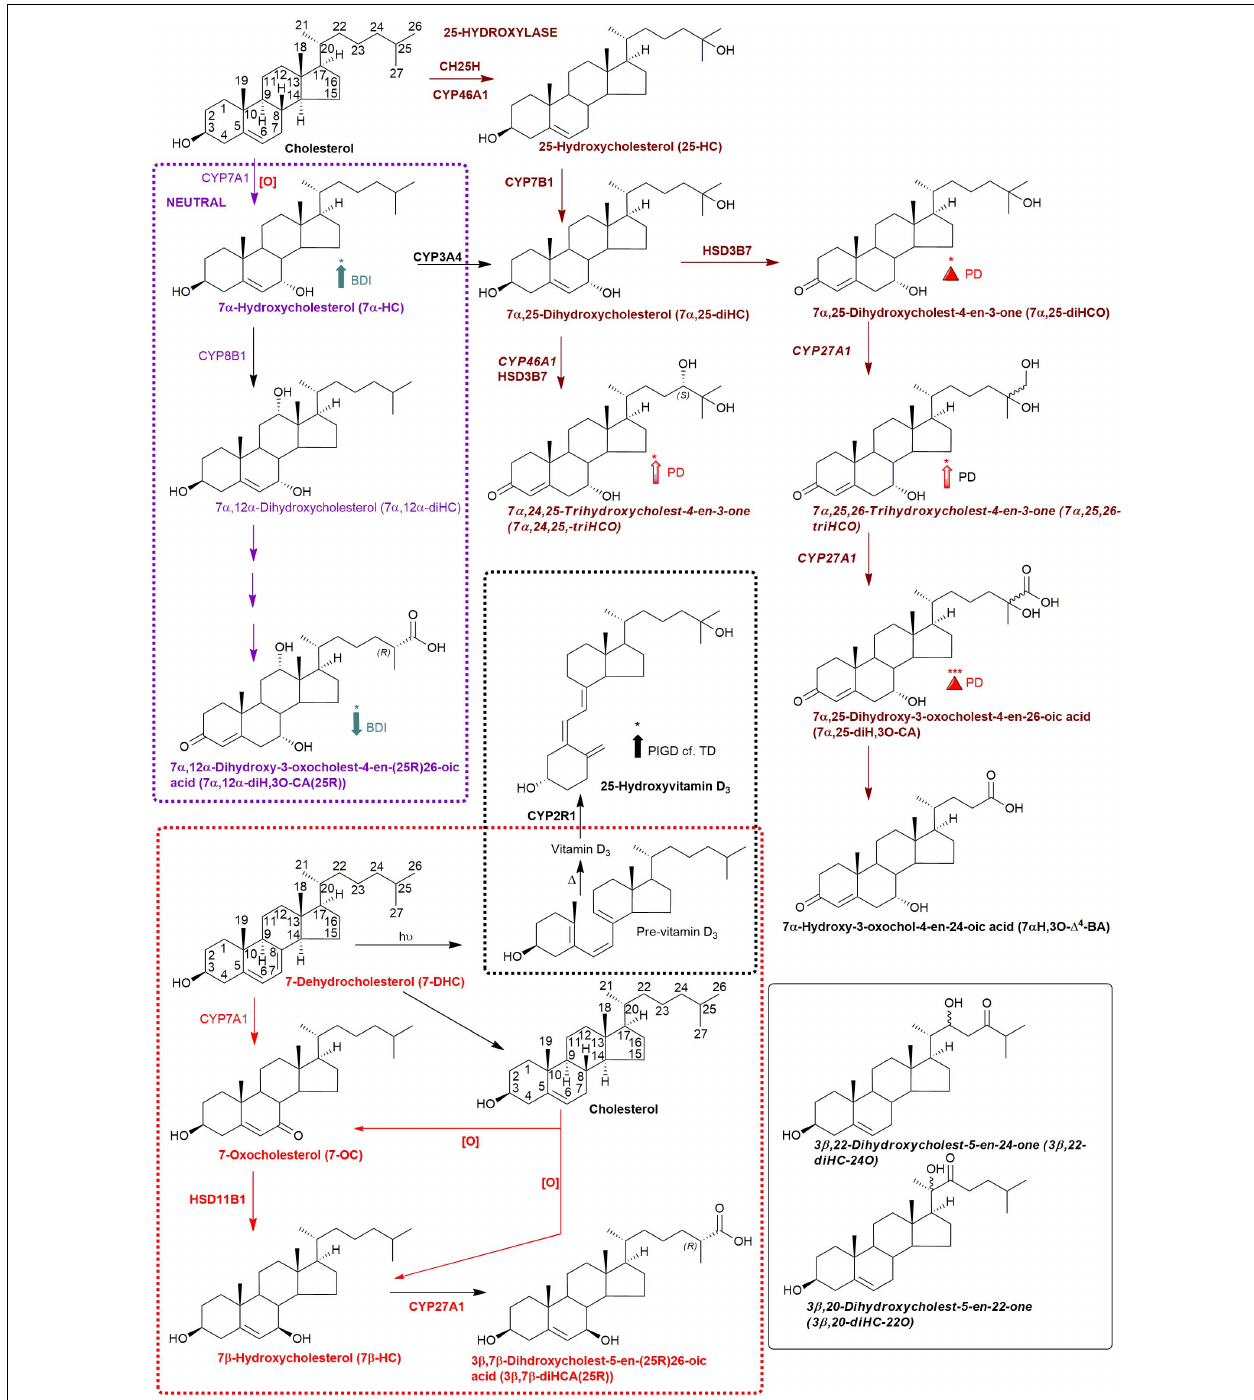
FIGURE 3 | Abbreviated versions of the early steps in the neutral (left, in purple) and the cerebral 25-hydroxylase (right, in brown) pathways of bile acid biosynthesis. Pathway from 7-dehydrocholesterol and cholesterol to 3 β ,7 β -diHCA(25R) are also shown as is the path to 25-hydroxyvitamin D 3 in red and black dashed boxes, respectively. Enzymes, metabolites, and reactions of the neutral pathway are in purple, those of the 25-hydroxylase pathway are in brown, while those generating 3 β ,7 β -diHCA(25R) are in red. Enzymes/genes expressed in brain, and metabolites observed in CSF are in bold. Italics indicate that the named structure is one of a number of possibilities. Enzymes in italics are postulated catalysts. [O] indicates oxidation via non-enzymatic mechanism. Thick coloured arrows pointing upwards or downwards indicate significant positive or negative correlations even when the confounding variables are considered. Red triangles indicate significance ignoring confounding variables, in at least one of the two studies. The full stereochemistry and numbering system for cholesterol and 7-DHC is indicated. Abbreviated structures are shown for other sterols ignoring ring-stereochemistry.